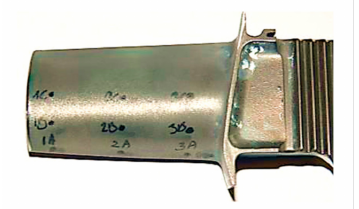
Figure 2. Places of impedance phase angle